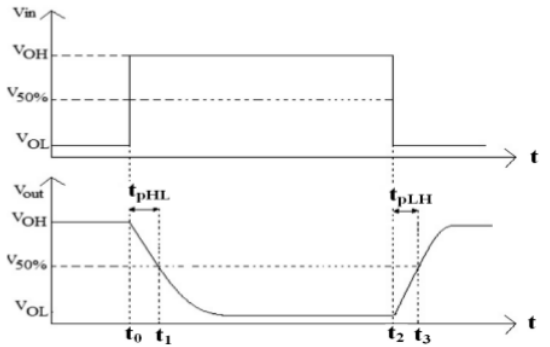
Figure 3: Input and output voltage waveforms of CMOS inverter and definitions of propagation delay